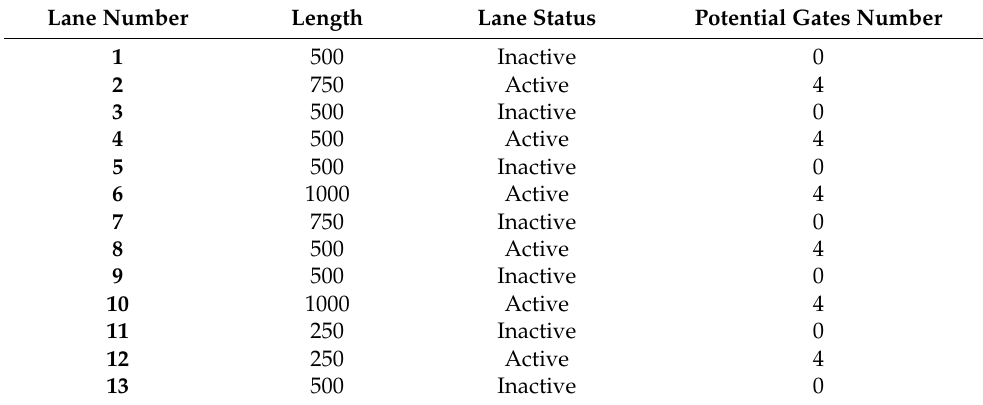
Table 2. Lane data.